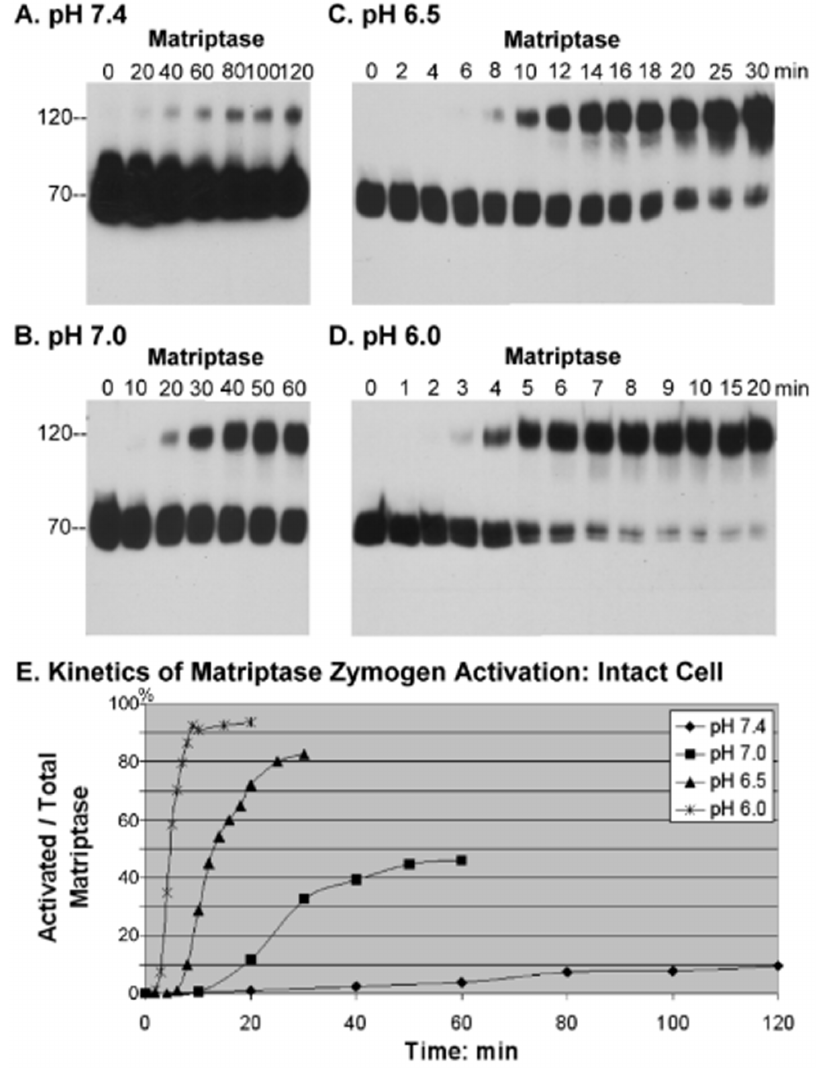
Figure 2. Time and pH-dependence of matriptase zymogen autoactivation in living cells. 184 A1N4 mammary epithelial cells were exposed to phosphate buffers at pH 7.4 (A), pH 7.0 (B), pH 6.5 (C) or pH 6.0 (D) at room temperature for the indicated time. Cell lysates were prepared and assayed by immunoblot analyses for matriptase using matriptase mAb M24. Matriptase zymogen was detected as a 70-kDa species and activated matriptase was detected as 120-kDa complex with HAI-1. (E) Kinetics of induction of matriptase activation in living cells. The ratio of activated matriptase relative to total matriptase (activated plus zymogen matriptase) for each pH was plotted against time using Image J.